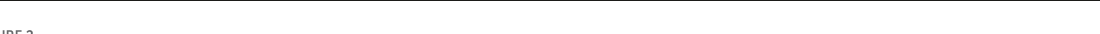
FIGURE2 respectively. (E–H) The corresponding data for PD patients. Note that for both ET and PD patients, linear and angular data obtained with either of the two sensors (finger-attached/smartphone) both resulted in relatively high classification performance (linear acceleration for finger and smartphone, respectively, ET AUC: P1/P2:0.969/0.976 and 0.992/0.958 and angular velocity for finger and smartphone, respectively, ET AUC P1/P2:0.938/0.976 and 0.966/0.983). and for PD (linear acceleration for finger and smartphone, respectively, PD AUC: P1/P2:0.918/0.925 and 0.921/0.889 and angular velocity for finger and smartphone, respectively, PD AUC P1/P2:0.886/0.909 and 0.857/0.873). Illustrations of tremor positions adapted from Isaacson et al. (2020). For panels (B,D,F,H) tremor index values were normalized to the population average of the control group and logarithmized for easier comparison.